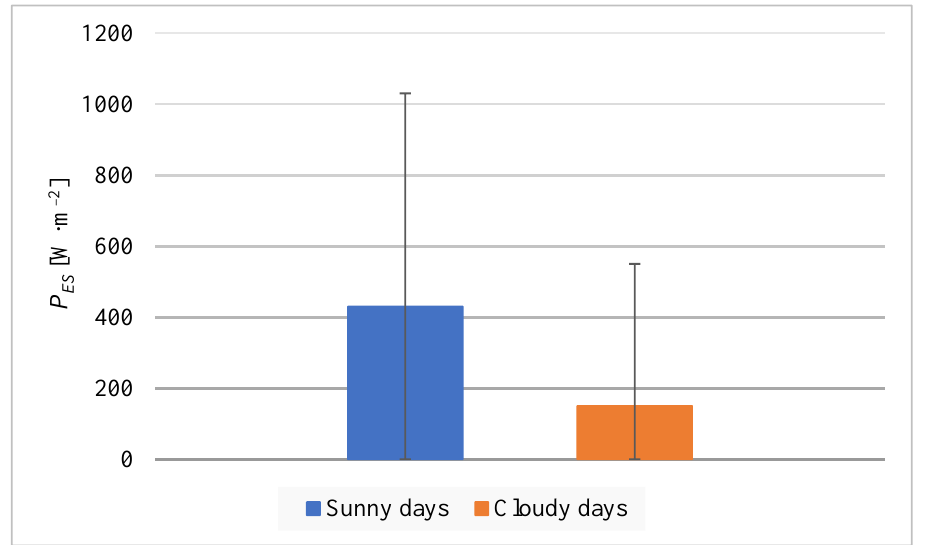
Figure 10. Average values of solar radiation intensity for sunny and cloudy days.